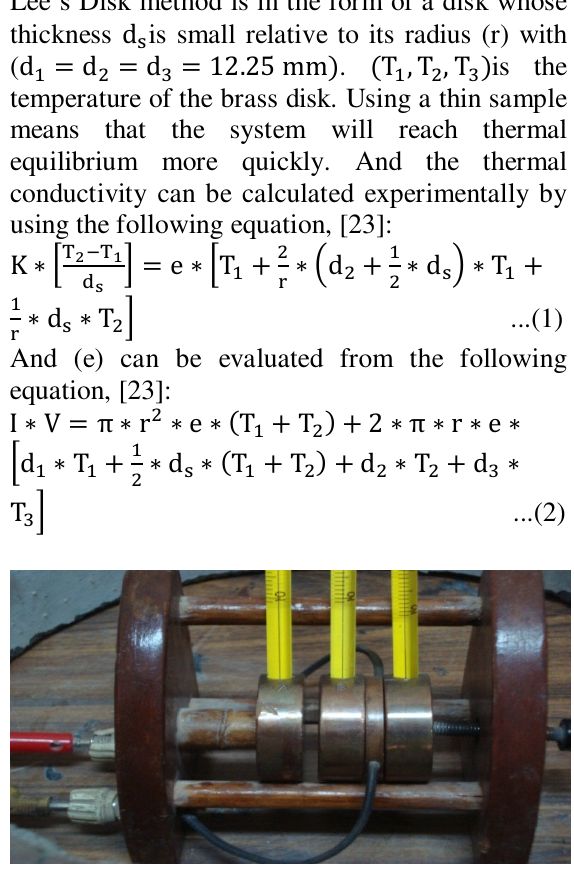
Fig. 8. (a) Hardness Shore D results for the